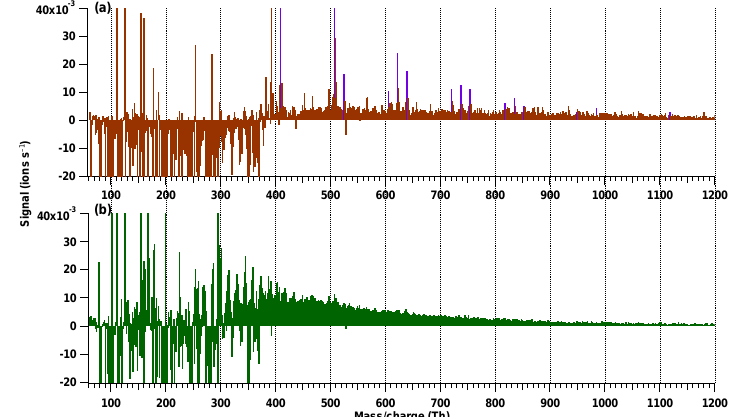
Figure 10. Difference of the negative mode mass spectra between two types of new particle formation and the average of 21 non-new particle formation sunny days (average signal of nucleation days − non-nucleation days). (a) 7 new particle formation events with H 2 SO 4 - NH 3 clusters (purple peaks); (b) 19 new particle formation events with